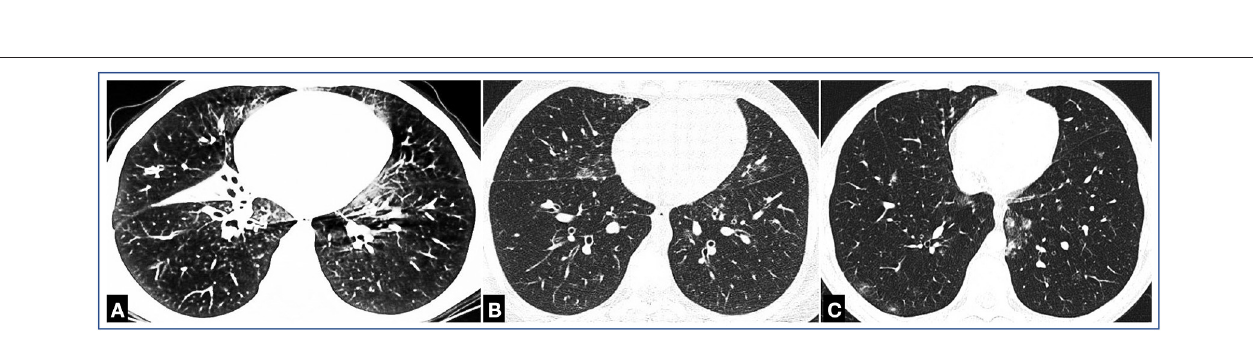
FIGURE 6 | Thoracic computed tomography (CT) imaging of patients with CVID with granulomatous lymphocytic interstitial lung disease (GLILD). (A) Multiple confluent nodules, tree-in-bud pattern reflecting bronchiolitis, interstitial pneumonia, peribronchial thickening and bronchiectasis, atelectasis, and fibrosis of the right middle lobe. (B) Patchy, confluent ground-glass opacities, tree-in-bud pattern, single nodules. (C) Multiple, irregular, disseminated perivascular and subpleural nodules, ground-glass